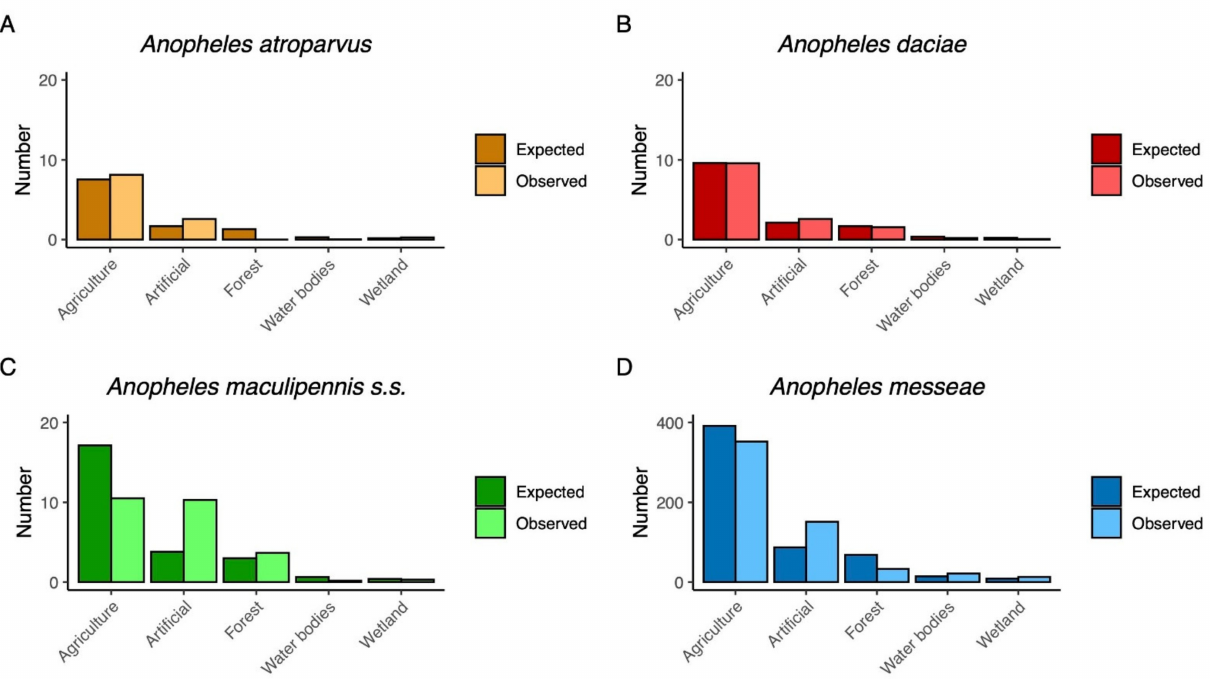
Figure 3. Expected distribution versus observed distribution per Land Cover Class of ( A ). An. at- roparvus ( n = 11), ( B ). An. daciae ( n = 16), ( C ) . An. maculipennis s.s. ( n = 25) and ( D ). An. messeae ( n = 478). Significant differences between observed and expected distributions were observed for An. messeae only (Fisher’s exact test, p <